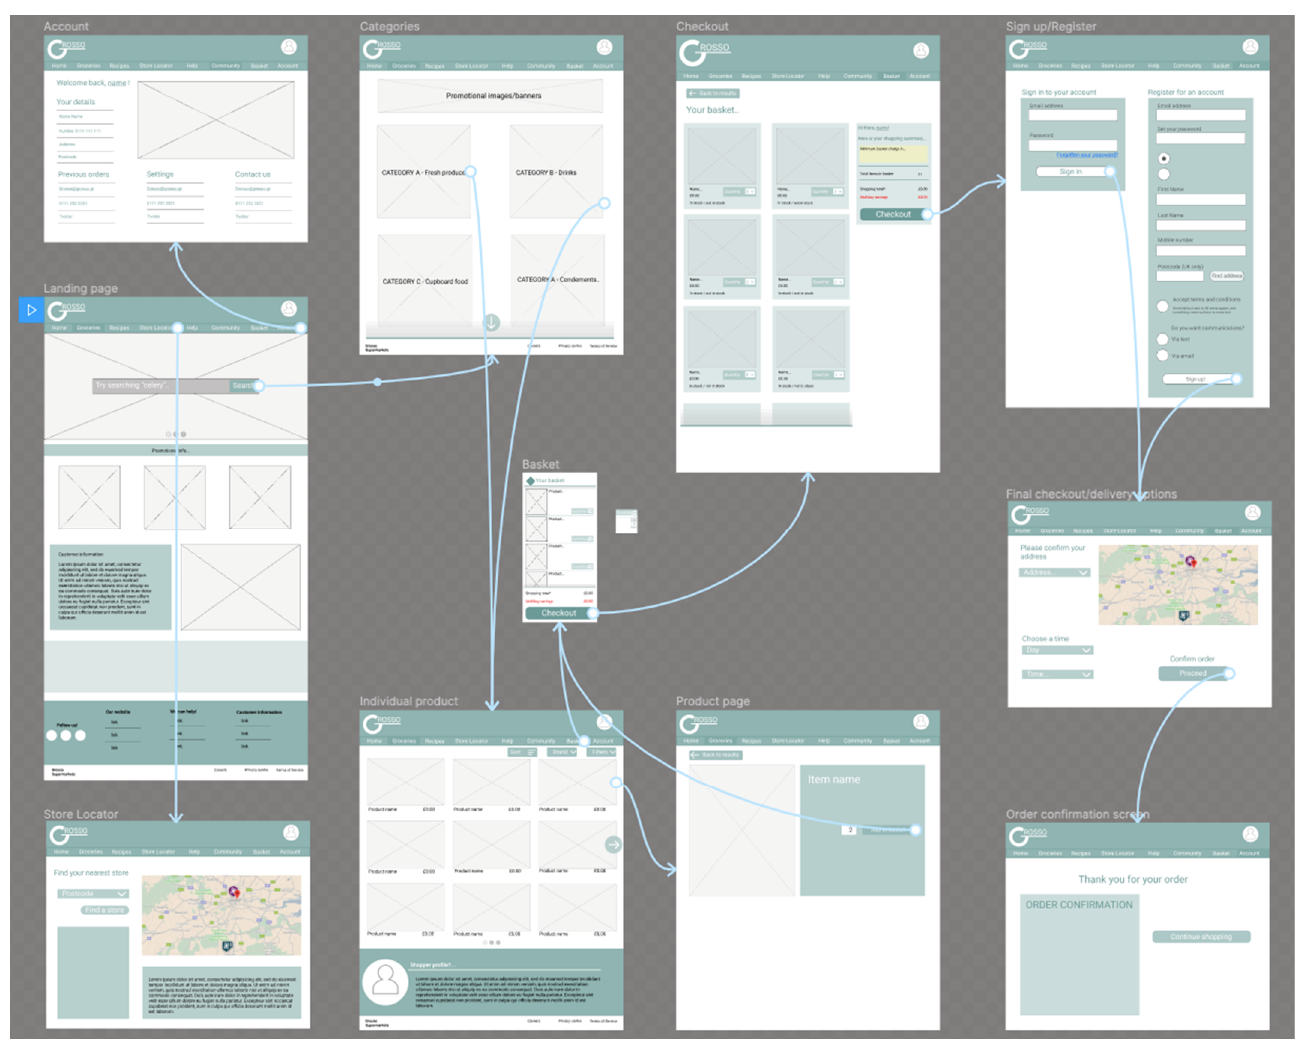
Figure 2. Low Fidelity Storyboard demonstrating the customer journey.